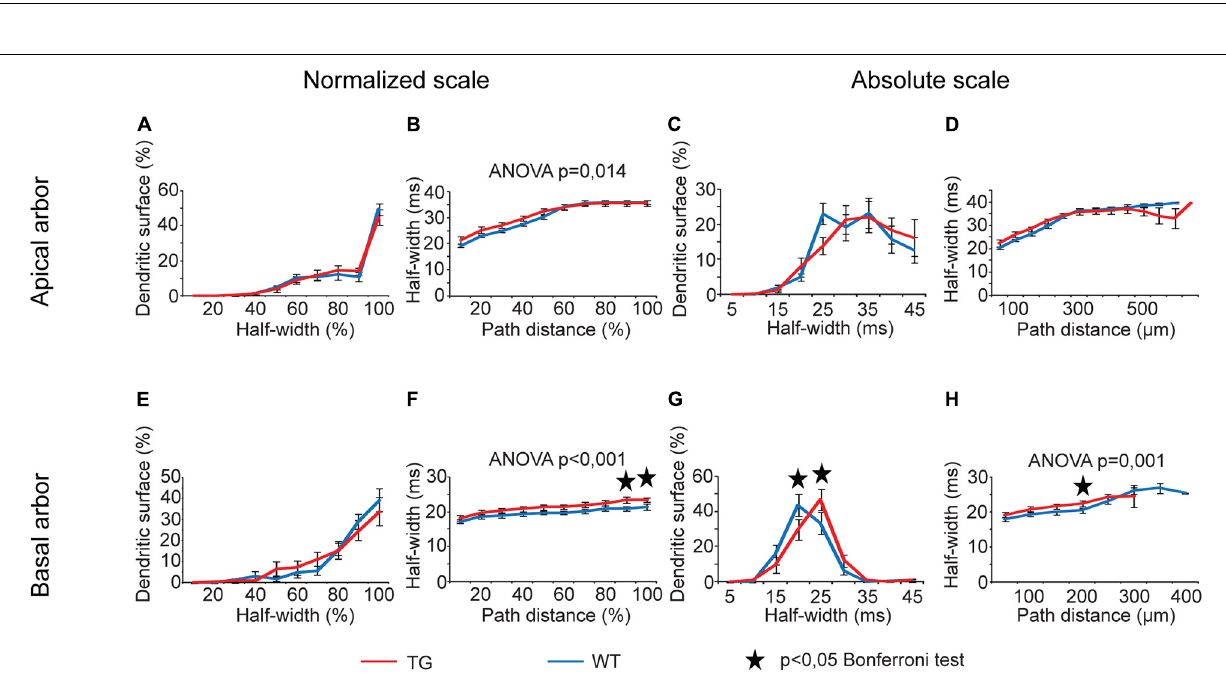
Frontiers in Neuroscience |